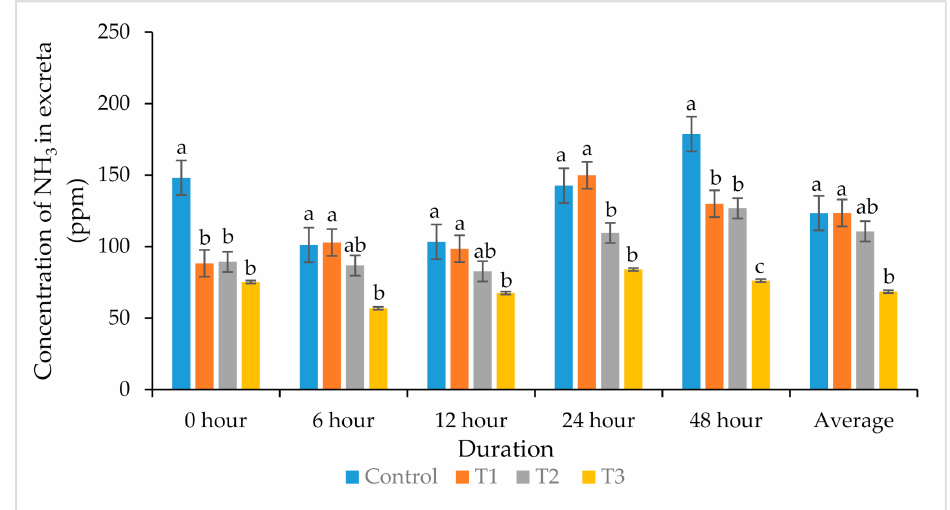
Figure 2. Effects of Mentha arvensis (MA) and Geranium thunbergii (GT) on concentration of NH 3 emis- sion from excreta. a,b,c Bars within a particular point not sharing a common letter differ significantly ( p < 0.05). n = Each value represents the mean of six replications with four birds per